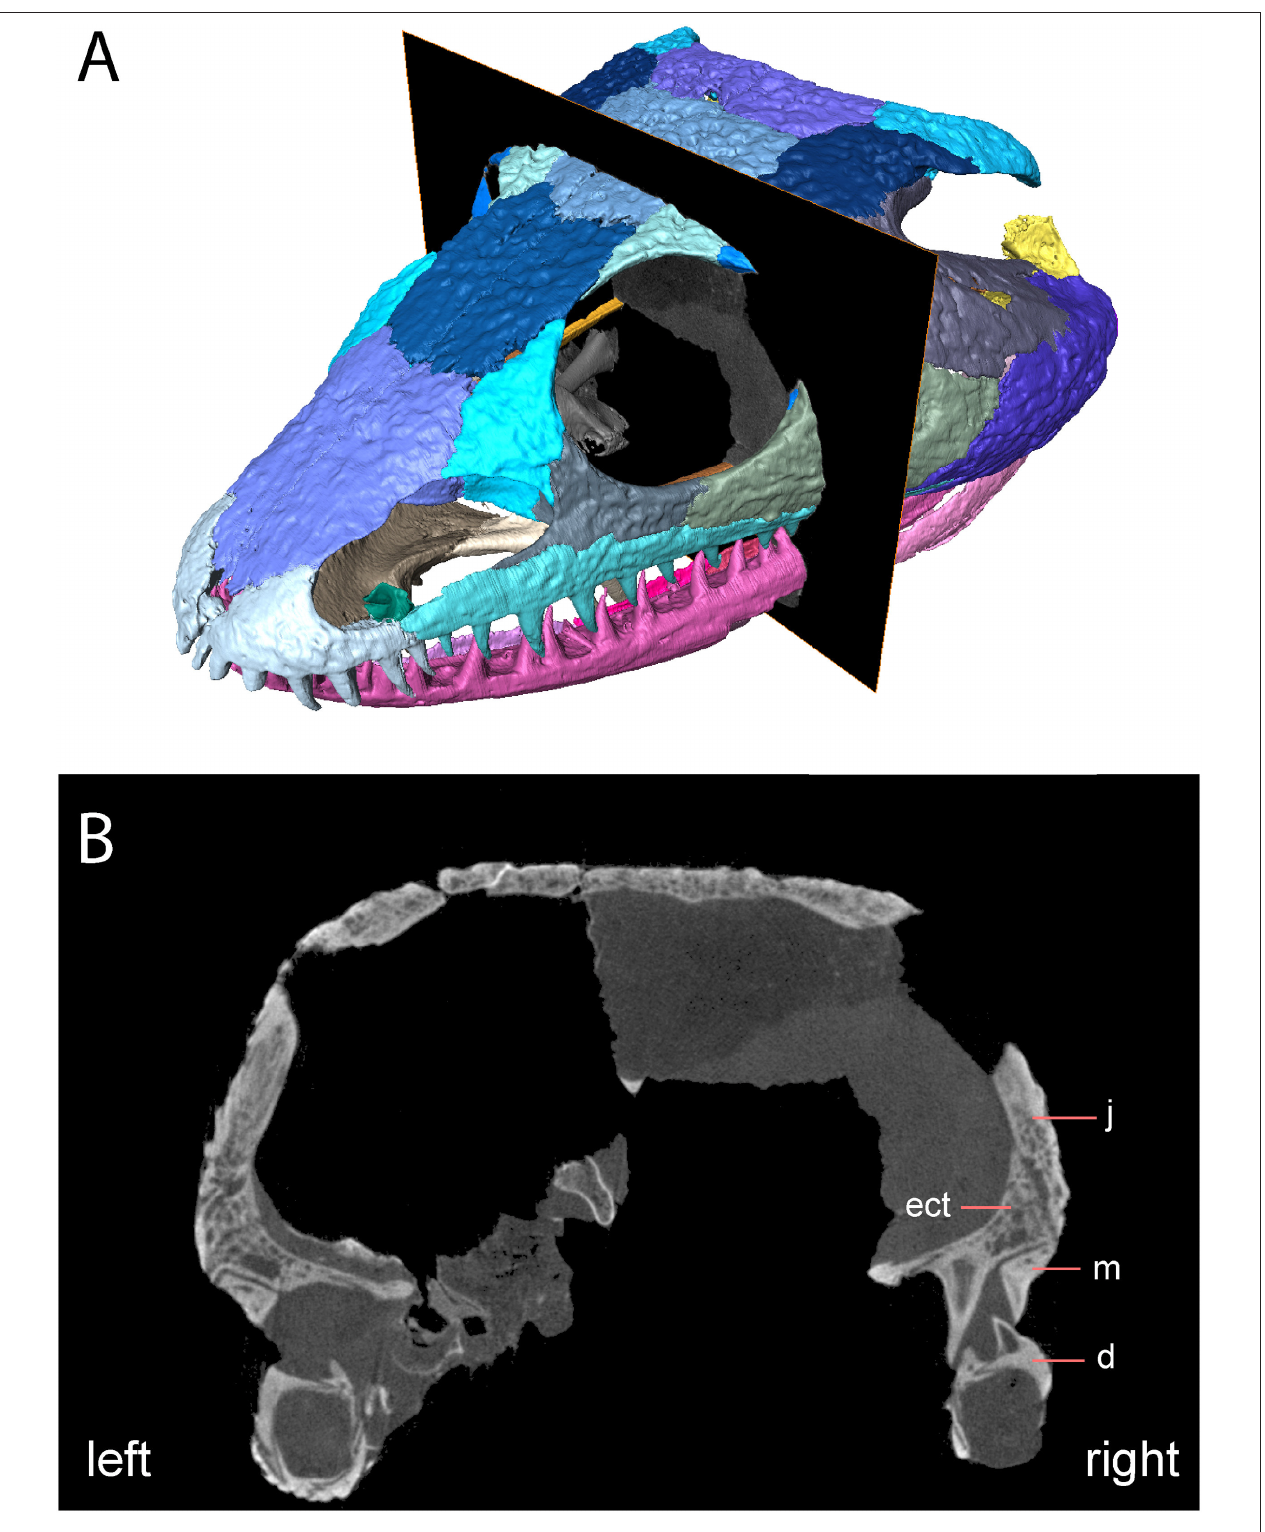
FIGURE 6 | OMNH 79318, cf. Acheloma , skull roof in anterolateral profile with digital slice showing trace of lateral exposure of the ectopterygoid. (A) Rendering of skull roof with transverse slice; (B) transverse digital slice showing sutural relationships of the ectopterygoid, the jugal, and the maxilla.